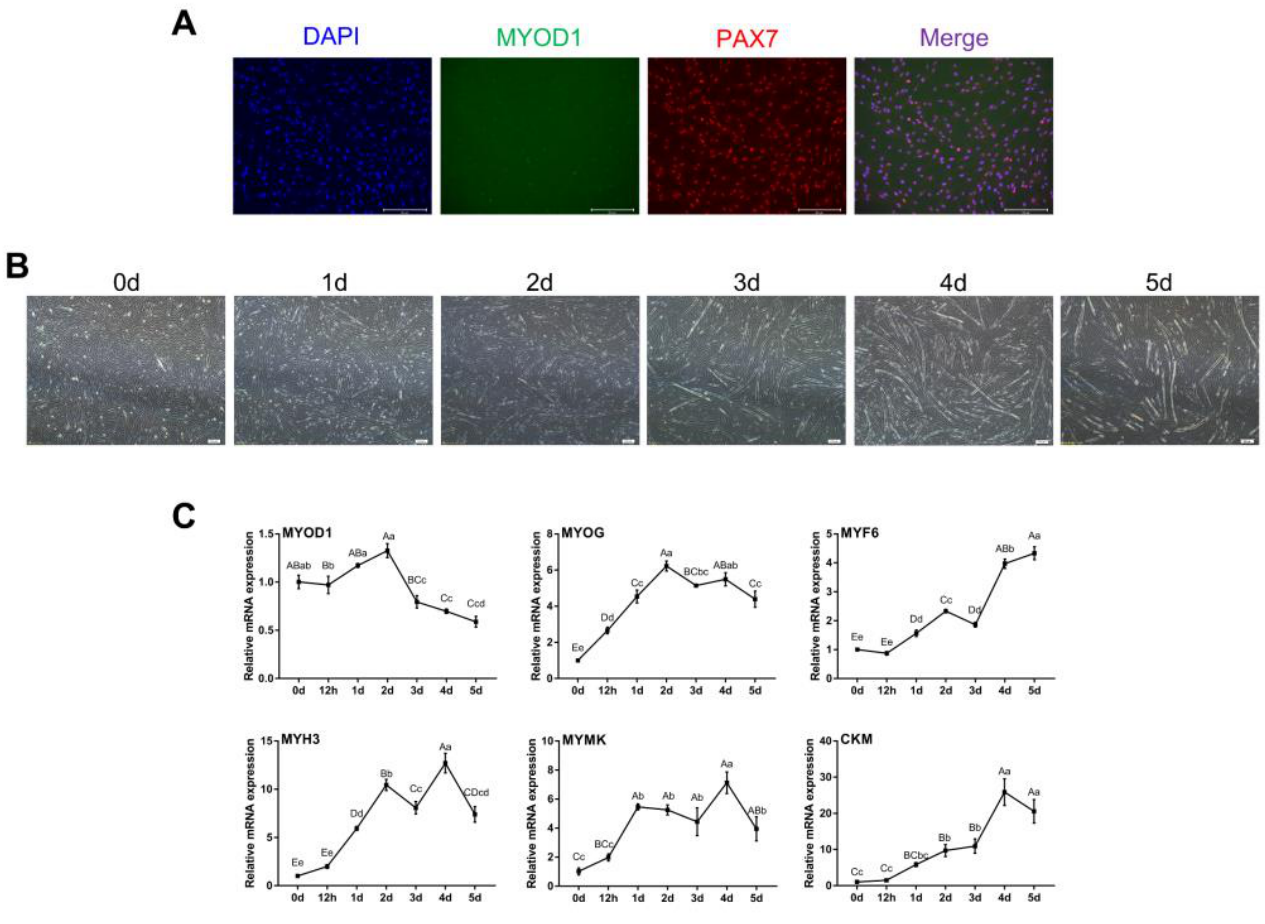
Figure 1. Identification of bovine skeletal myoblasts. ( A ) Identification of myoblasts by immunofluorescence based on MYOD1 (green) and PAX7 (red) expression at 48 h of growth (scale bar: 200 μm). Nuclei were counterstained with DAPI (blue). ( B ) Myotube formation on days 0, 1, 2, 3, 4 and 5 after induction of myogenic differentiation (bright field, scale bar: 200 μm). ( C ) Relative mRNA expression of skeletal-specific myogenic genes ( MYOD1 , MYOG , MYF6 , MYH3 , MYMK and CKM ) during myoblast differentiation. The results were normalized to GAPDH levels and are presented as the means ± SDs from three independent experiments. Different capital letters indicate very sig- nificant differences ( p < 0.01), different lowercase letters indicate significant differences ( p < 0.05), and the same letters indicate no significant differences ( p > 0.05) using one-way ANOVA with Tukey’s correction.